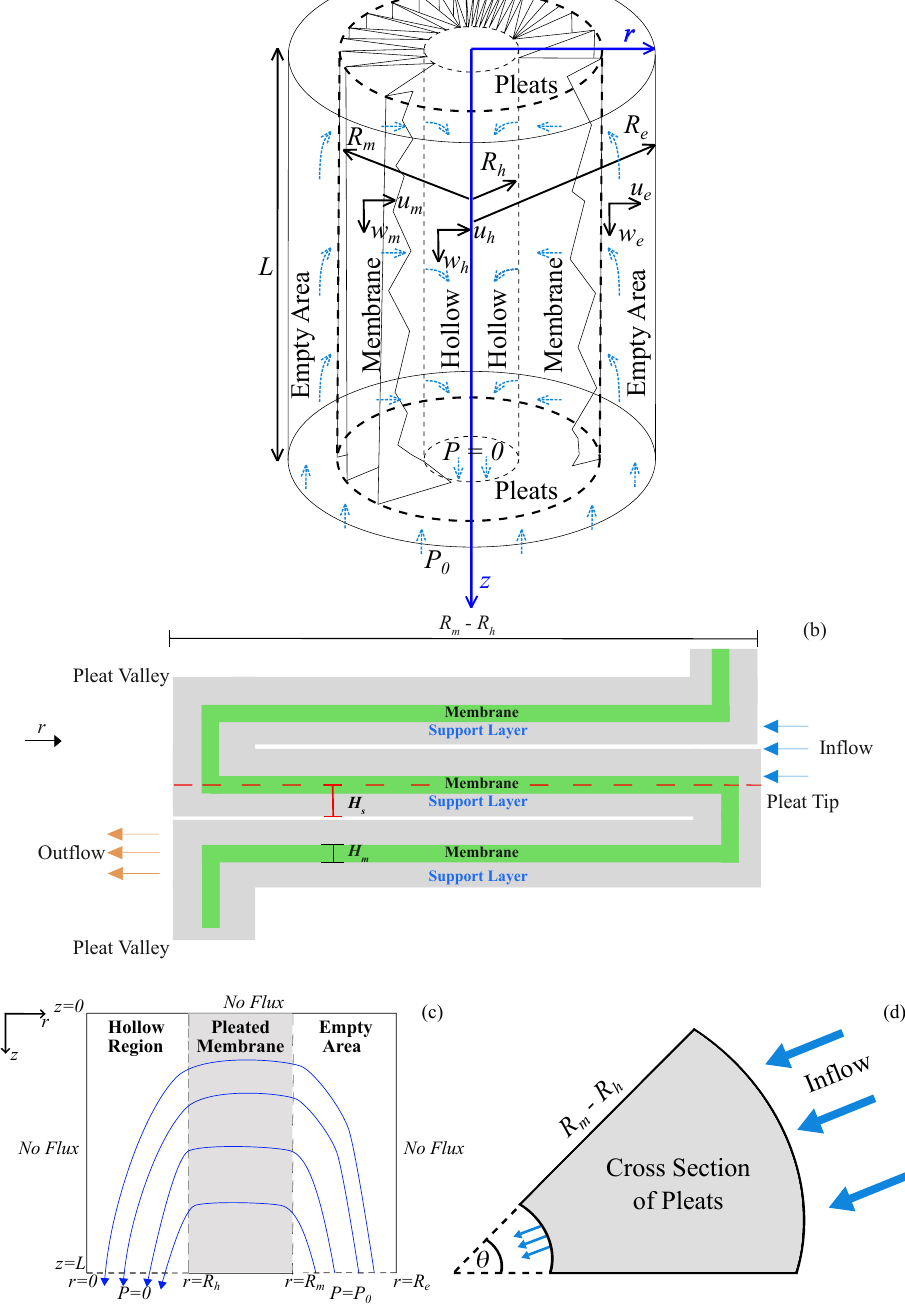
Figure 1. ( a ) Schematic of the pleated filter cartridge with height L , containing (i) a hollow duct with radius R h ; (ii) a pleated membrane with the pleat length of R m − R h ; and (iii) an empty area with an outer radius R e . ( b ) A close-up of the pleats with the membrane layer and two support layers with thicknesses of H m and H s , respectively. ( c ) The inlet specified pressure drop is P 0 at z = L and R m < r < R e , while the outlet specified drop is 0 at z = L and 0 < r < R h . The flow velocity is ( u ) , where i ∈ { h , m , e } are for the hollow region, membrane and empty area, respectively. A i , w i no-flux condition is applied at the top of the cartridge ( z = 0), as well as its center and walls ( r = 0 and r = R e ). ( d ) Cross section of the filter cartridge with pleat length of R m − R h , where θ represents the angle that sweeps across the given pleat. The filtrate enters from the empty area and travels through the pleat, exiting to the hollow